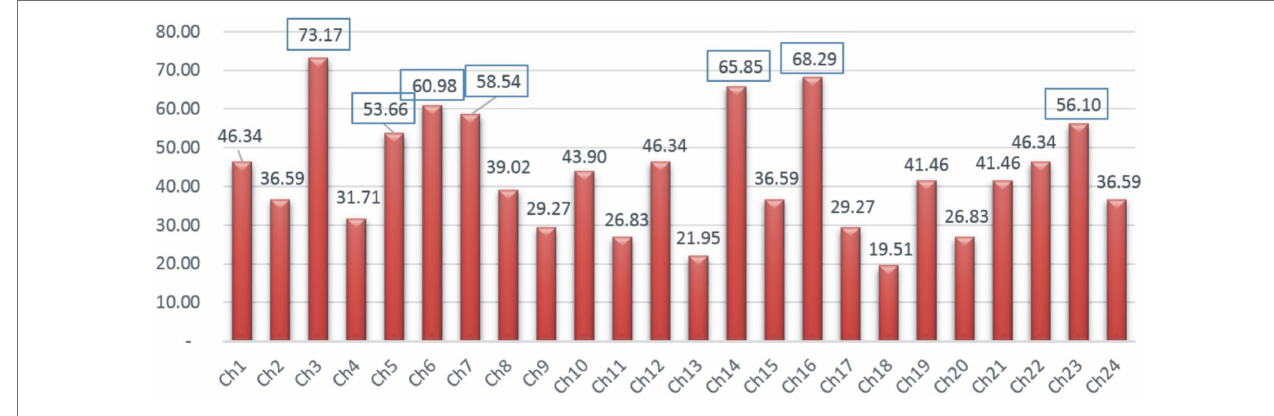
FIGURE 4 | Frequency analysis of identified